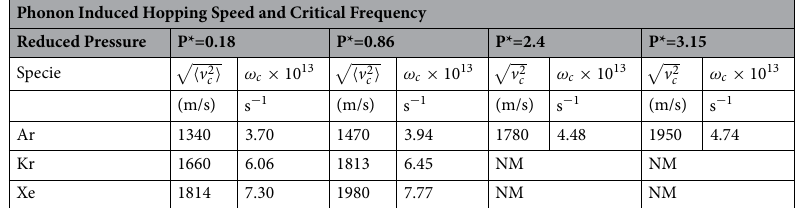
Table 1. According to the proposed model of phonon-driven self-diffusion, over the portion of the frequency spectrum where liquid dynamics are solid-like, ω F (cid:31) ω (cid:31) ω d , the instantaneous velocity of any given nucleus is determined by superposition of 3 N independent, phonon-induced velocity contributions: v ( t )